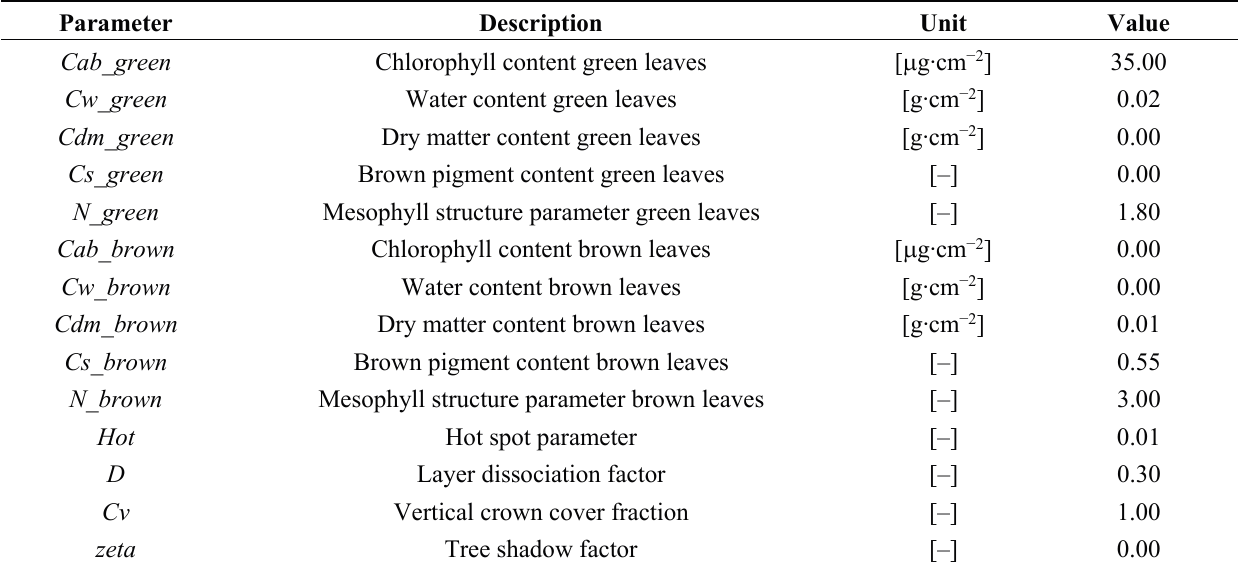
Table 3. Leaf/canopy optical properties used for reflectance modeling of wheat canopies with